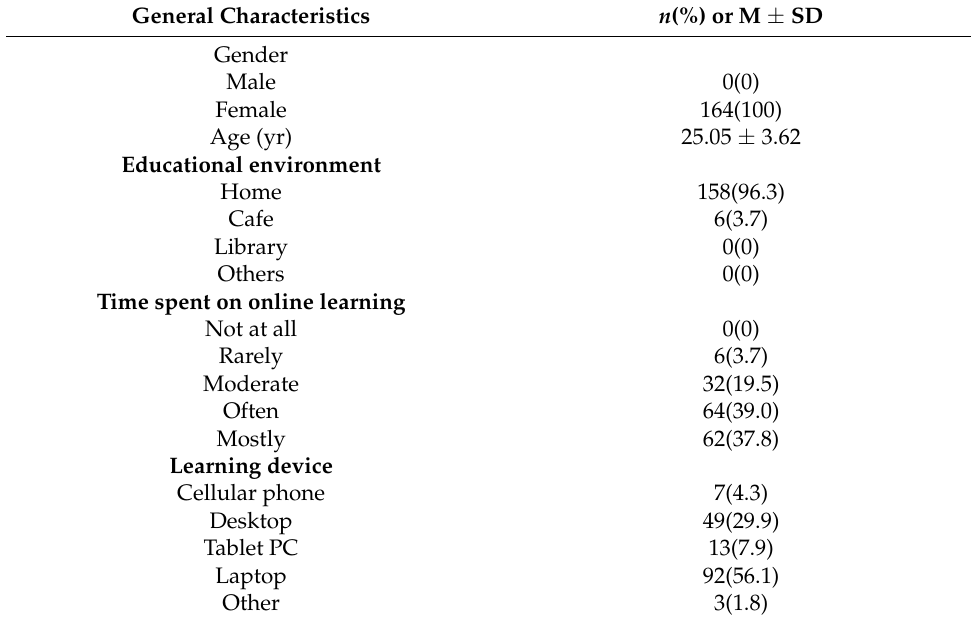
Table 2. Demographic Characteristics of the Participants ( N =